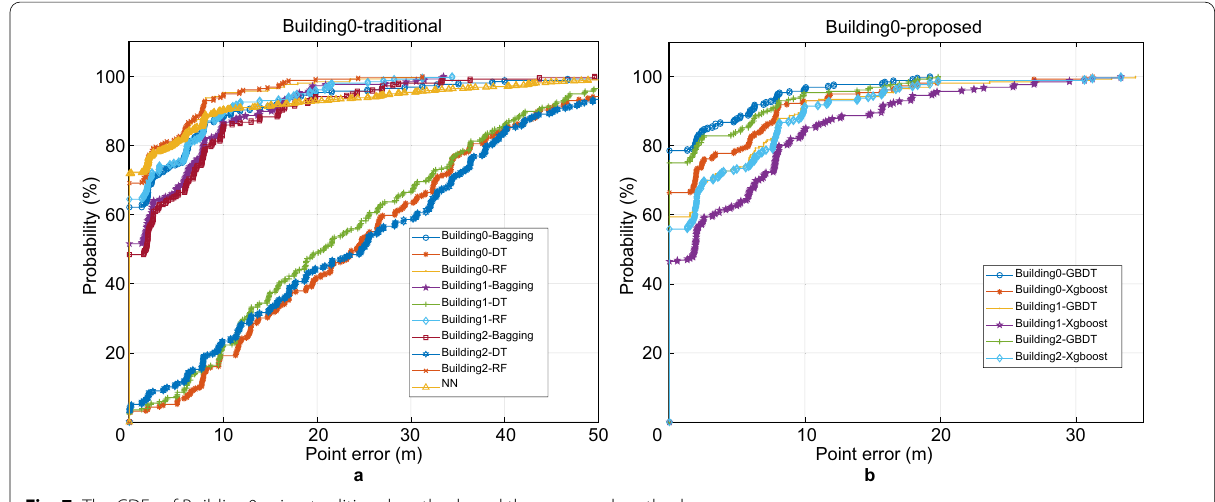
Fig. 7 The CDFs of Building0 using traditional methods and the proposed